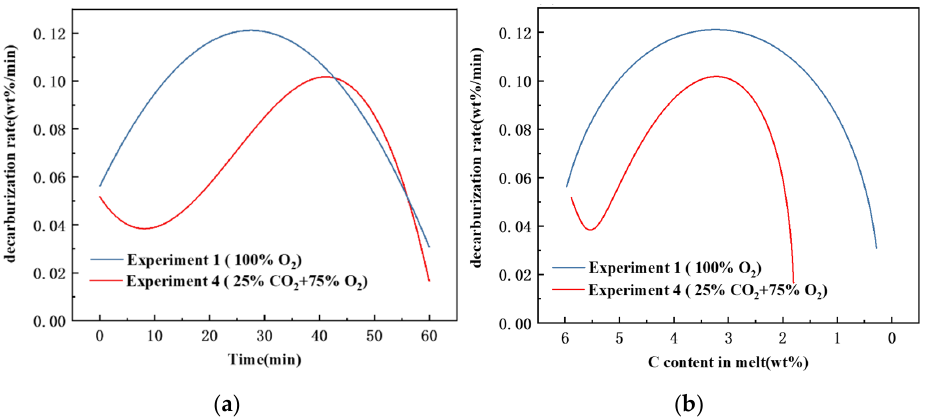
Figure 13. Variation in decarburization rate when blowing 25%CO 2 + 75%O 2 and 100%O 2 : ( a ) varia ‐ tion in decarburization rate with time; ( b ) variation in decarburization rate with C content in the melt.